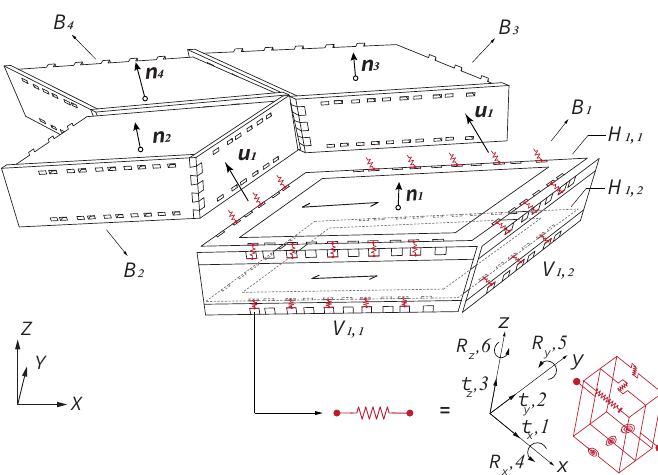
Figure 11. Semi-rigid spring model: plates were modelled as conventional shell elements and wood-wood connections as springs with six degrees of freedom (three translations and three rotations). Adapted